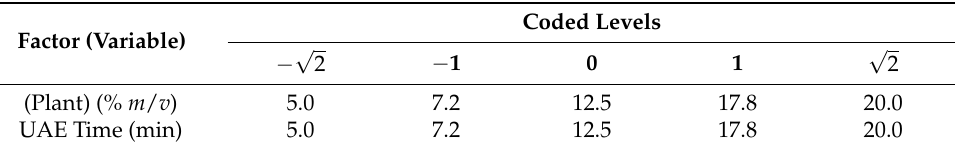
Table 1. Levels (values) of the factors (variables) used (UAE time and lyophilized plant concentration) in CCRD experiments for ultrasound-assisted extraction of bioactive compounds from Crithmum maritimum to sunflower